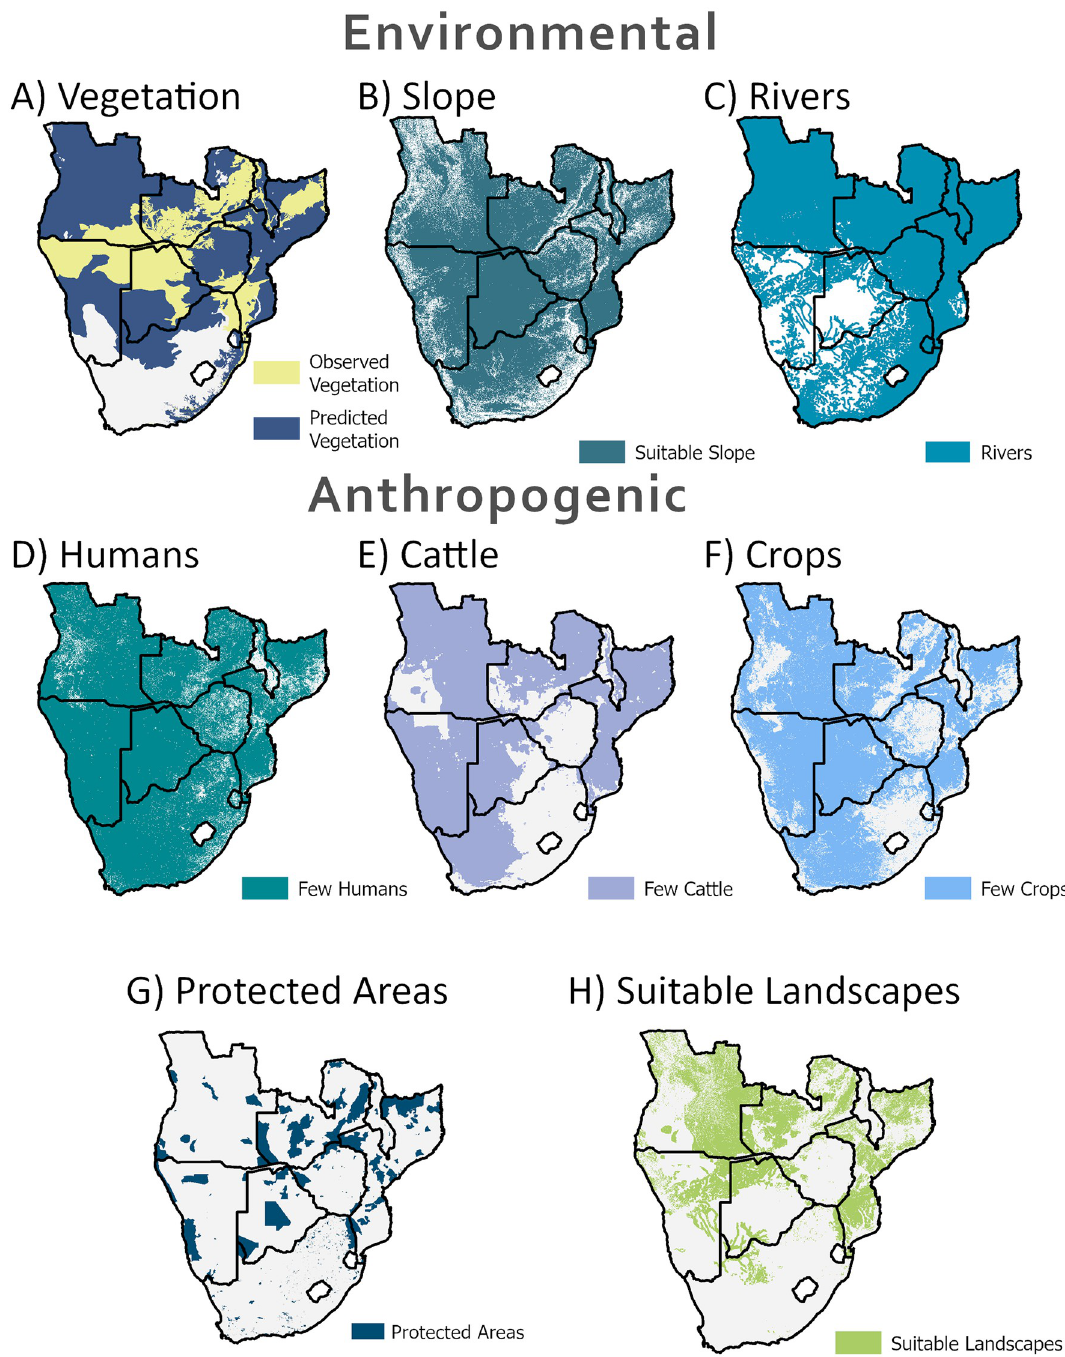
Fig 1. Composite of suitable areas for elephants for individual spatial layers. Areas suitable for elephants are calculated for each geospatial data separately. These include vegetation (A) [29], slope (B) [28], distance to rivers (C) [30], human population (D) [31], cattle density (E) [32], crop probability (F) [33], and protected areas (IUCN I-VI) (G) [35]. The intersection of these seven layers provides our projection of suitable landscapes for elephants (H).